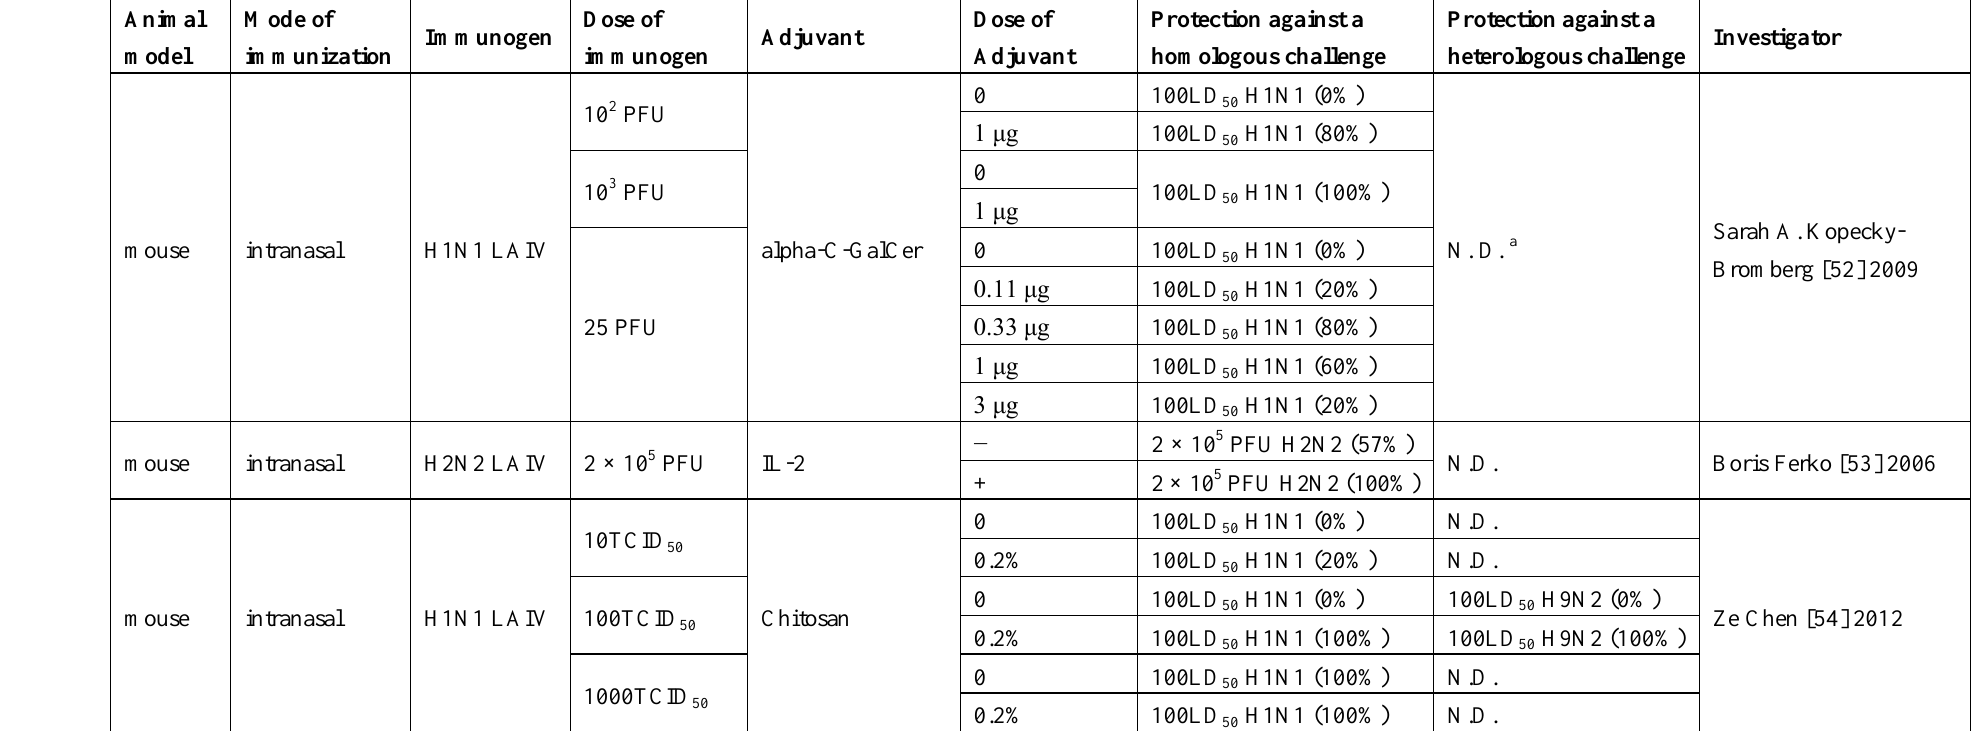
Table 2. Outlines of studies on adjuvanted